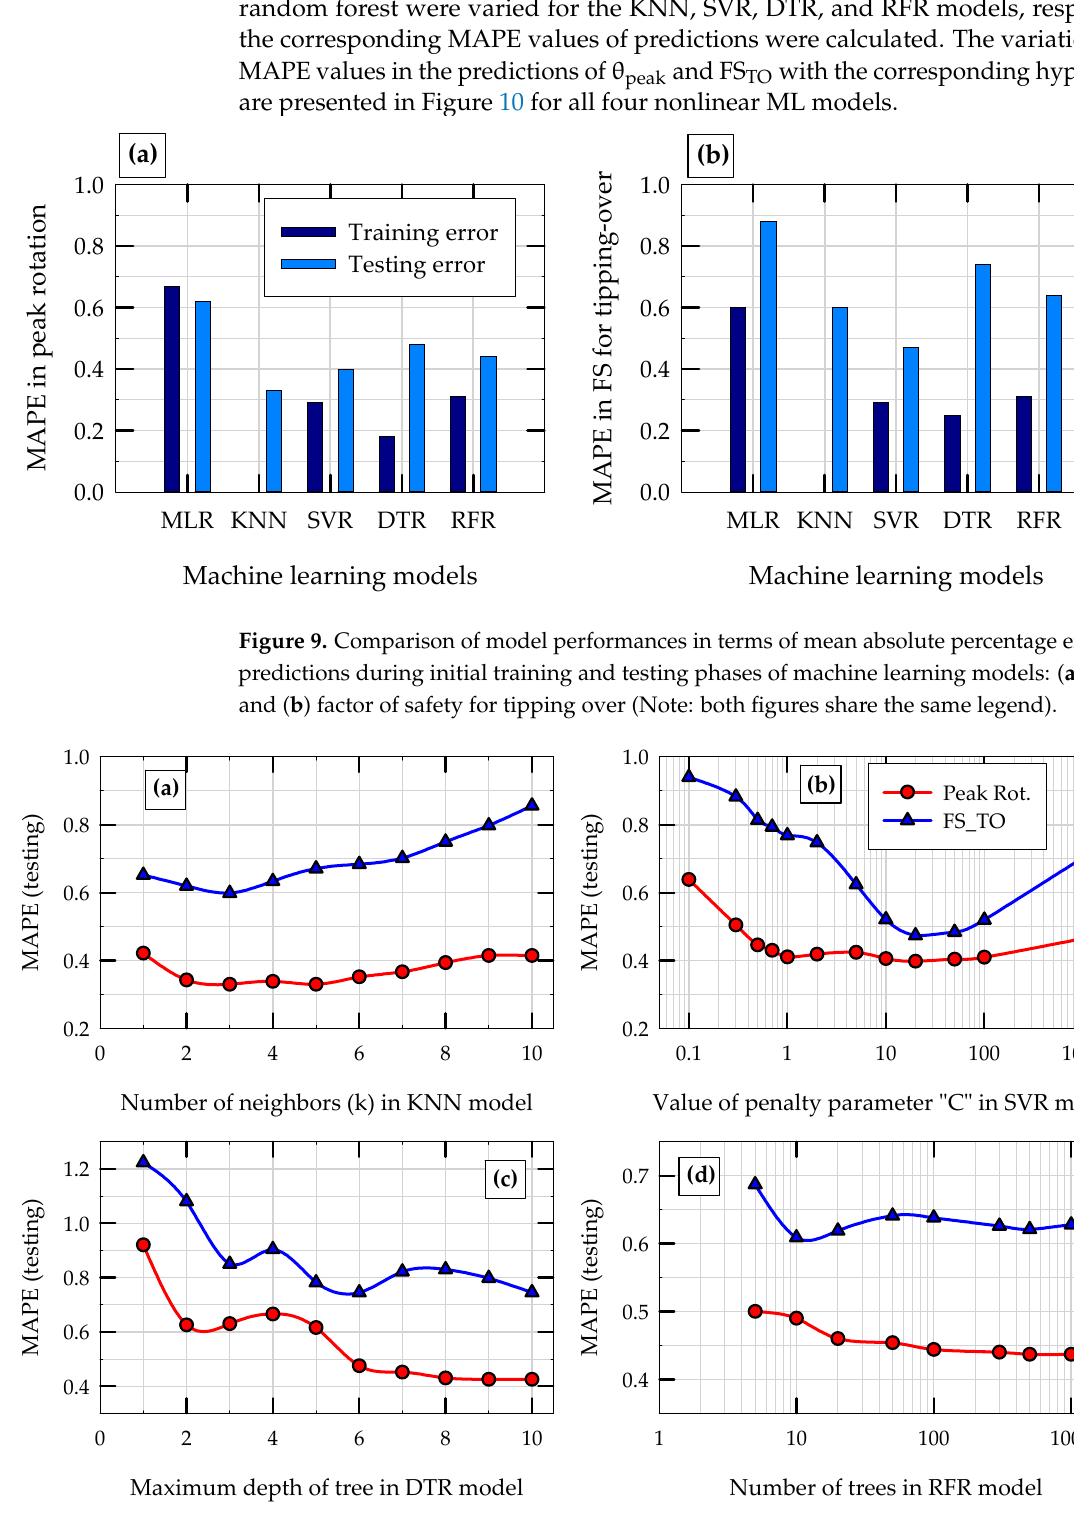
Figure 10. Results of hyperparameter tuning of machine learning models: variation of mean absolute percentage error (MAPE) during initial testing phase of the models with ( a ) number of nearest neighbors (k) in KNN model, ( b ) the value of penalty parameter “C” in SVR model, ( c ) maximum depth of tree in DTR model, and ( d ) number of trees in RFR model (Note: all four figures share the same legend).